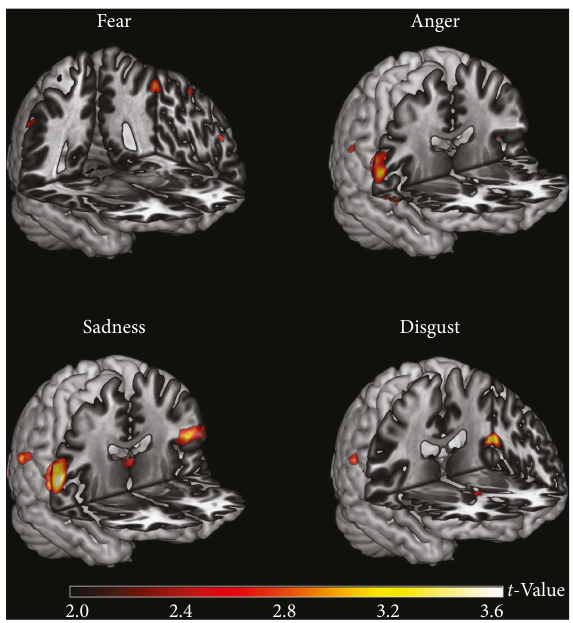
Figure 1: Regions showing increased fMRI activation in nonmedicated, nondemented PD patients ( n = 17 ) compared to healthy controls ( n = 22 ). PD patients may exhibit a general stronger recruitment of parietal regions when observing pictures of facial expressions depicting disgust, fear, sadness, and anger (image reproduced from Wabnegger et al. [209] under the Creative Commons license (CC-BY), no permission